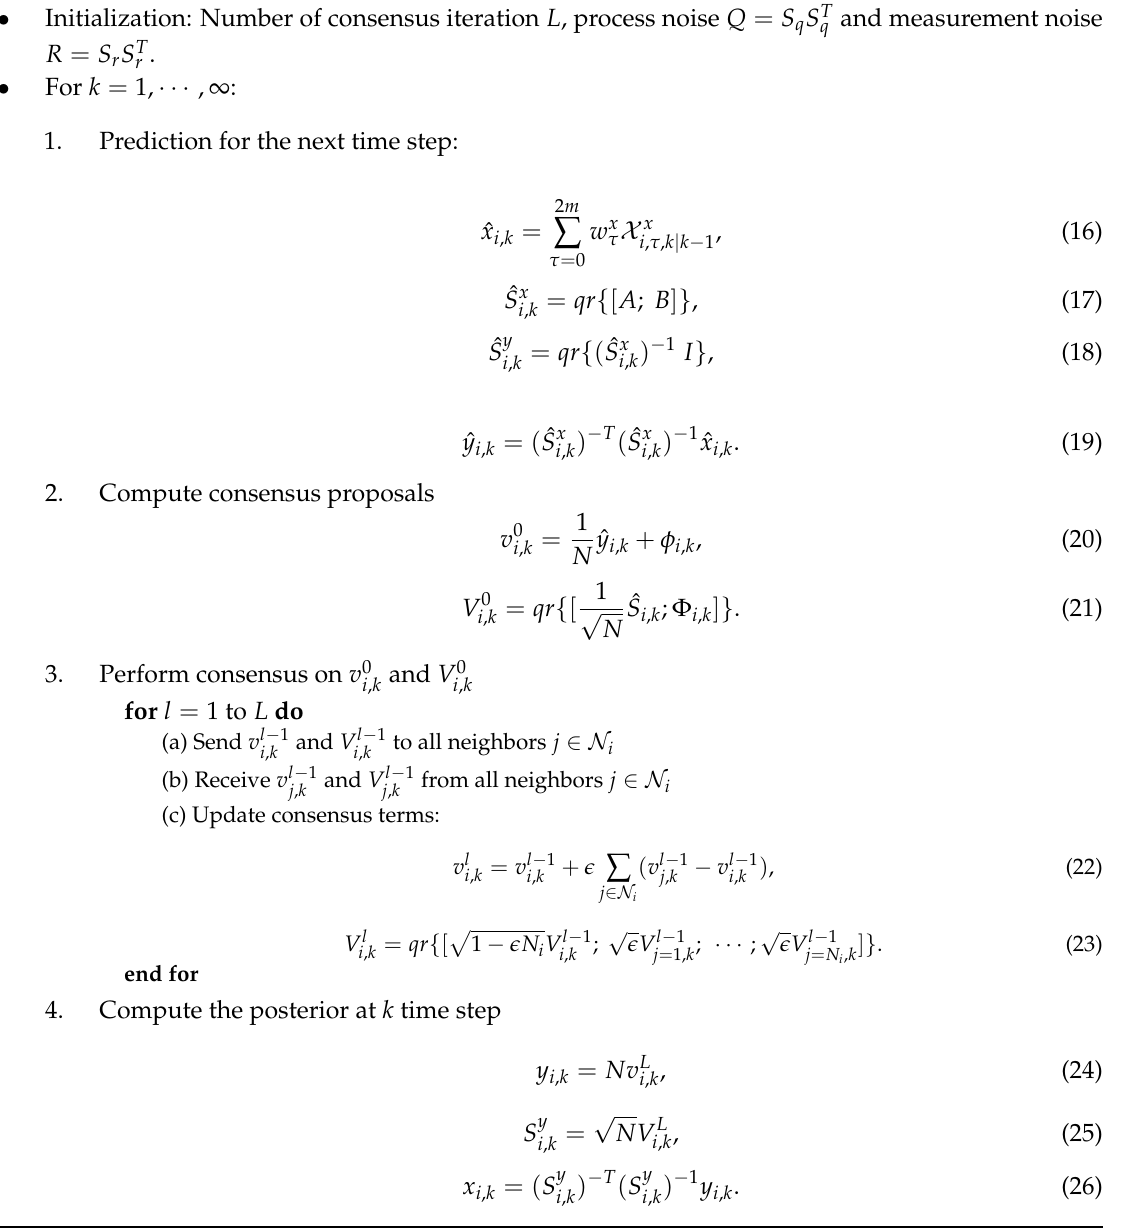
Algorithm 2 Square-Root Central Difference Information Weighted Consensus Filter